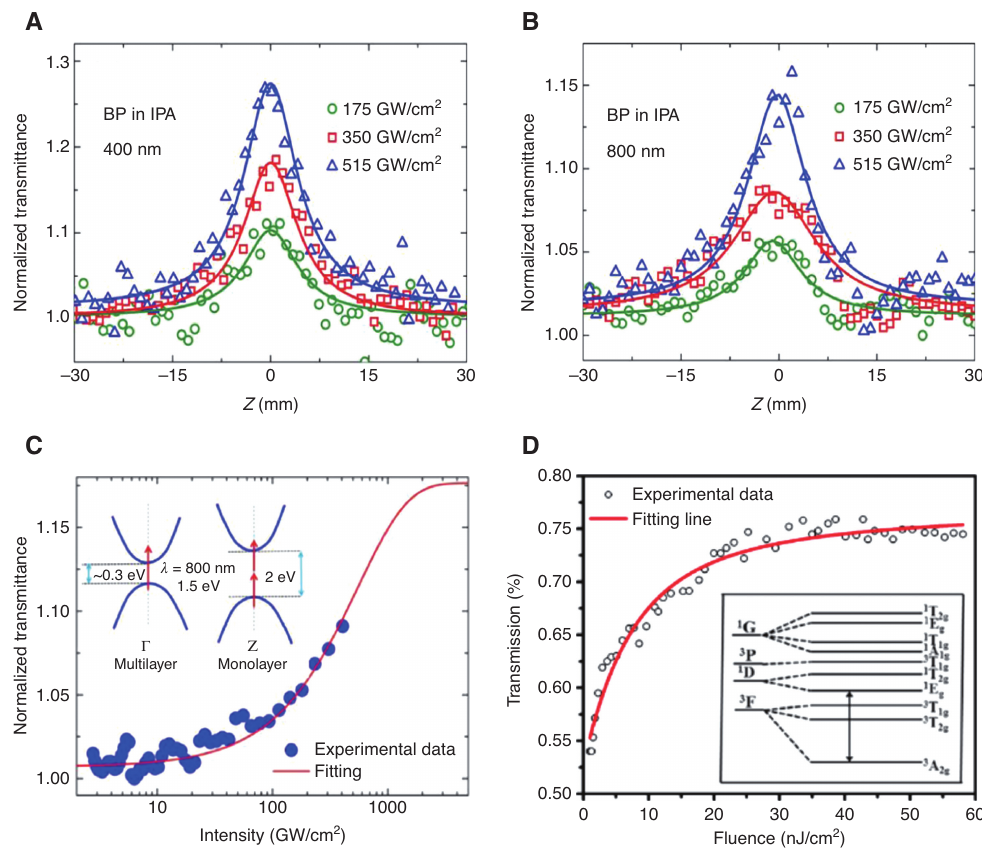
Figure 5: Nonlinear saturable absorption properties of nanomaterial SAs in visible spectral range. (A) and (B) are the open-aperture Z-scan measurements of BP NP dispersions at 400 and 800 nm. (C) Normalized transmittance curve of BP NP dispersions at 800 nm. (D) Transmission curve of NiO nanosheets at 720 nm; inset: schematic energy level diagram of Ni 2 + 3d 8 configurations. (A)–(C) Adapted from Ref. [125], Copyright 2015, Optical Society of America. (D) Adapted from Ref. [161], Copyright 2018, Optical Society of